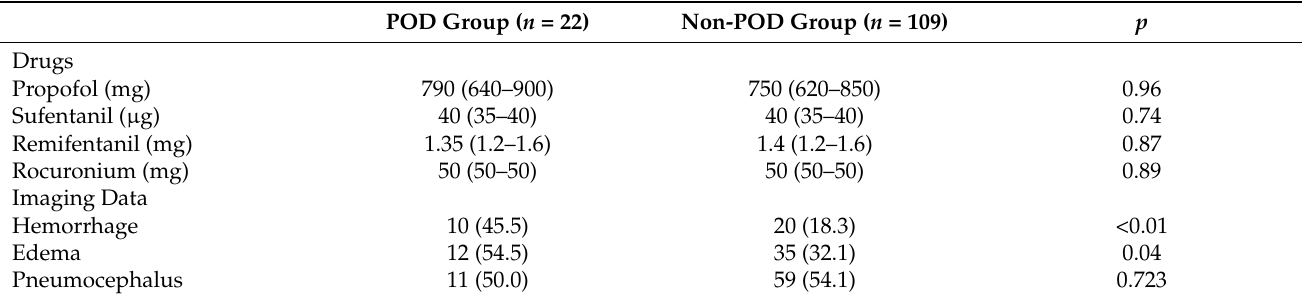
Table 3. Anesthetics and postoperative brain CT imaging data.